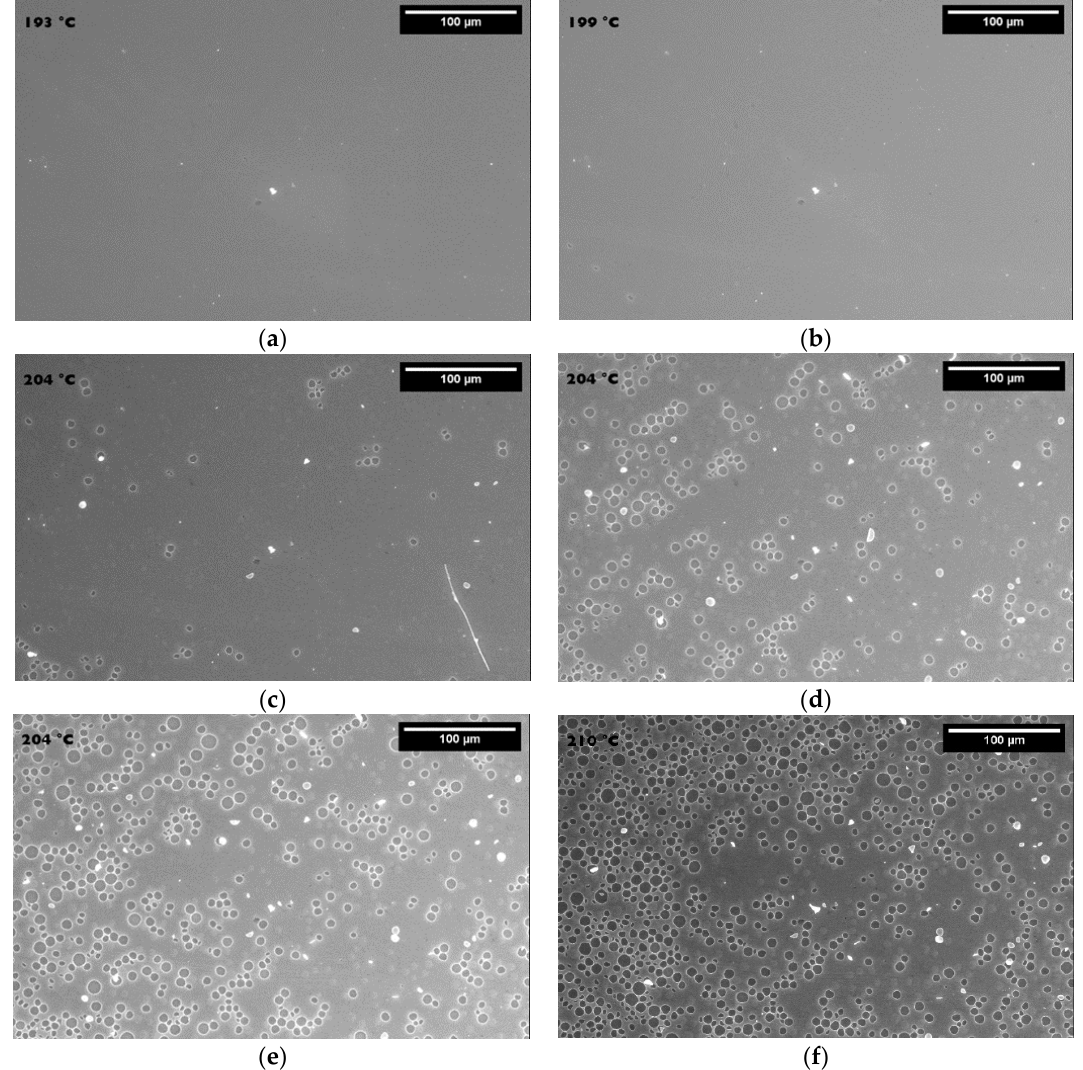
Figure 7. Evolution of the film surface morphology by ESEM for various temperatures. ( a ) 193 °C; ( b ) 199 °C; ( c–e ) 204 °C; ( f ) 210 °C.